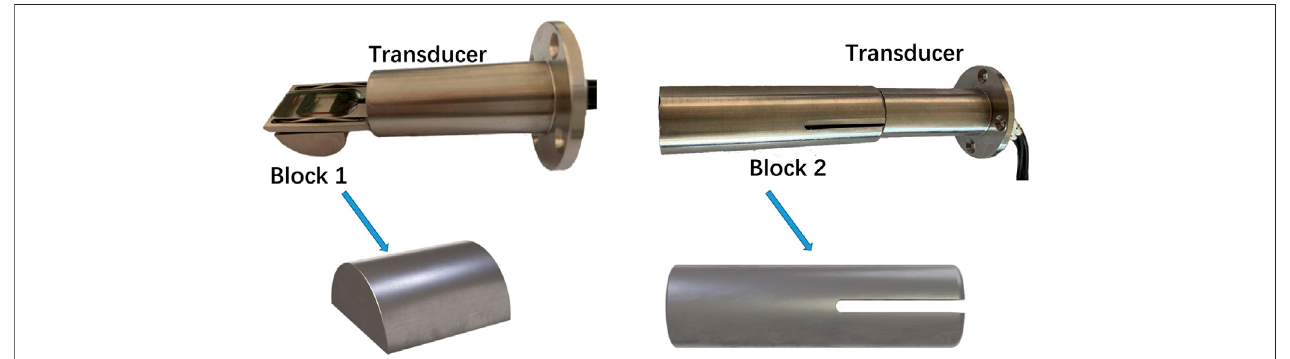
FIGURE 6 | Transducer testing using the designed blocks.